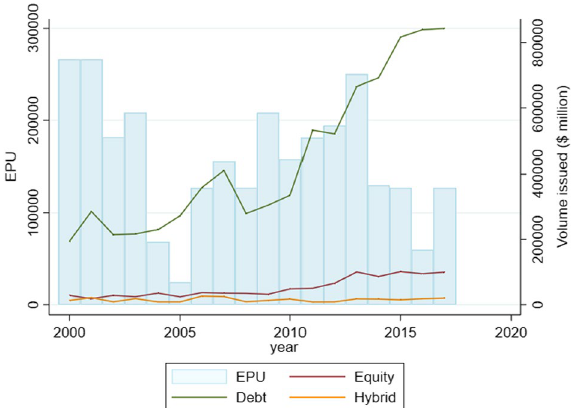
Fig. 2 Volume issuance data of sample firms from 2000 to 2017 (2018 is omitted because of incomplete data for that year). The EPU index is scaled to match the issuance trend in volume. The y-axis on the left shows the scaling for the EPU index, while the y-axis on the right shows the dollar volume of capital raised